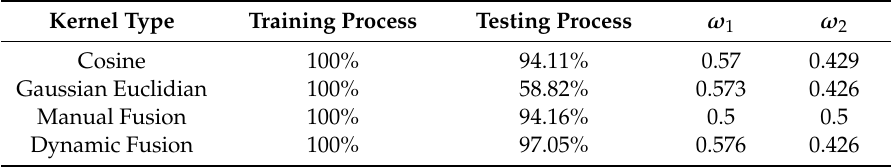
Table 3. Results of the training and testing process for different kernels.